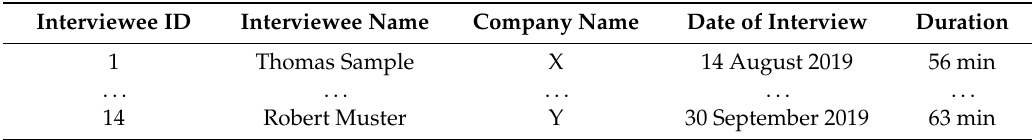
Table 2. Evaluation sheet 1, basic information on